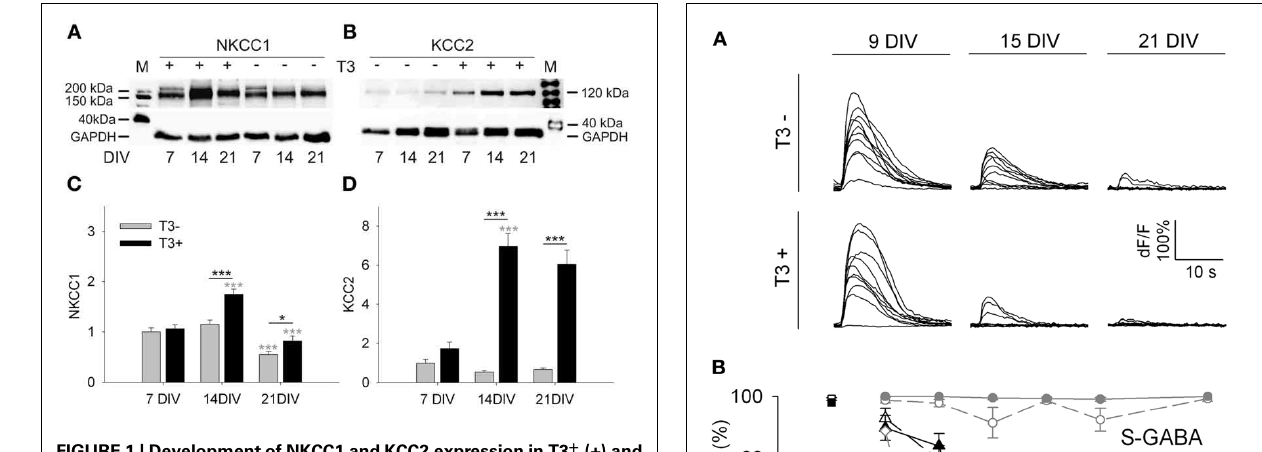
FIGURE 1 | Developmentof NKCC1 and KCC2 expression in T3 + (+) and T3 − ( − ) networks. Representative Western blots of 7 to 21-day-old cultures stained for NKCC1 (A) or KCC2 (B) . Expression of NKCC1 and KCC2 was increased in T3 + cultures compared with T3 − cultures at 14 and 21DIV. NKCC1 protein expression increased between 7 and 14DIV, but decreases again until 21DIV (A,C) . KCC2 protein expression did not change in function of age in T3 − cultures. In contrast, KCC2 expression in T3 + cultures increased markedly during the second week in vitro ( B , D ). Black asterisks show statistical significant differences between T3 + and T3 − networks; Gray asterisks show age-dependent differences. M, lane with molecular weight marker proteins. GAPDH protein level was used as a loading control. Values in graphs (C,D) were normalized to the T3 − value at 7DIV.